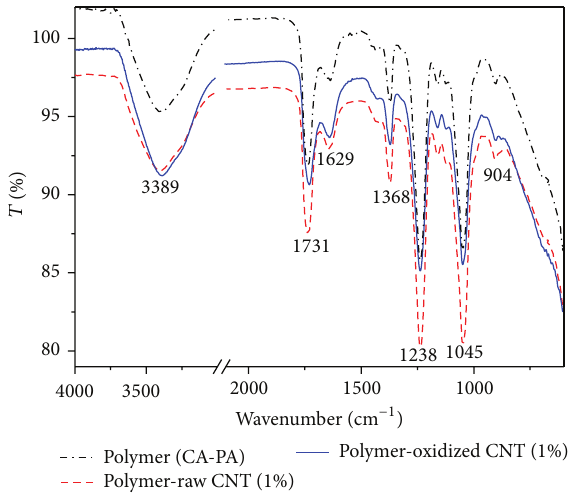
Figure3:Infraredspectraofthepolymer(AC-PA)withoutandwith raw and oxidized